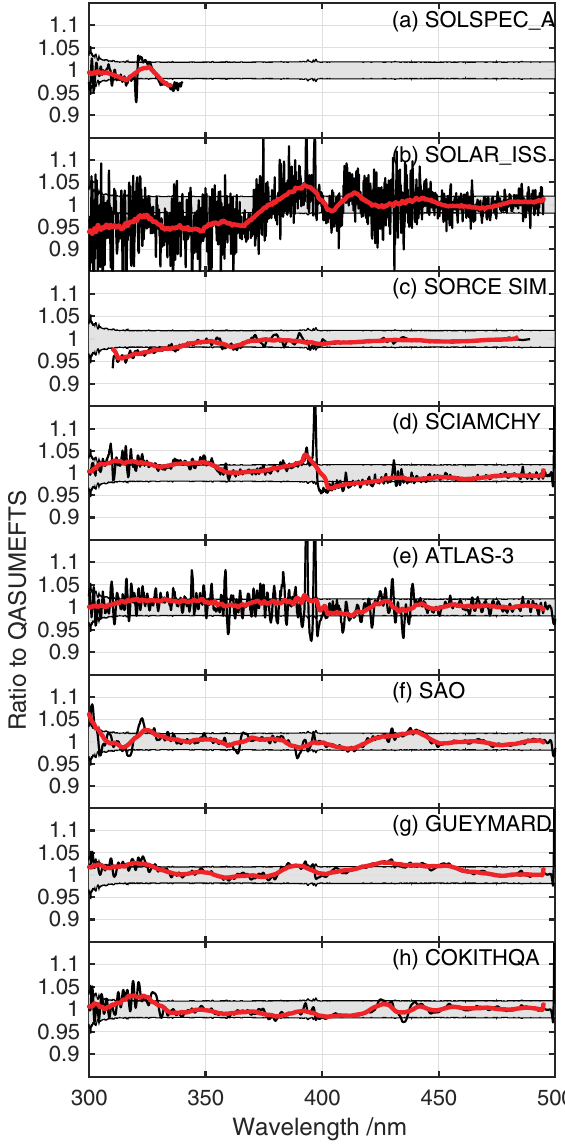
Figure 6. From (a) to (h) : ratios between QASUMEFTS and the solar ET spectrum from SOLSPEC (SOLSPEC_A by Bolsée et al., 2017, and SOLAR_ISS by Meftah et al., 2016), SORCE SIM (Harder et al., 2010), SCIAMACHY (Hilbig et al., 2017), ATLAS-3 (Thuillier et al., 2003), SAO (Chance and Kurucz, 2010), the com- posite from Gueymard (2003) and the composite from Egli et al. (2012). The black lines are the ratios convolved with a 1nm wide triangular slit function, while the red line is a 10nm running aver- age. The grey shaded area represents the expanded uncertainty of the QASUMEFTS spectrum.